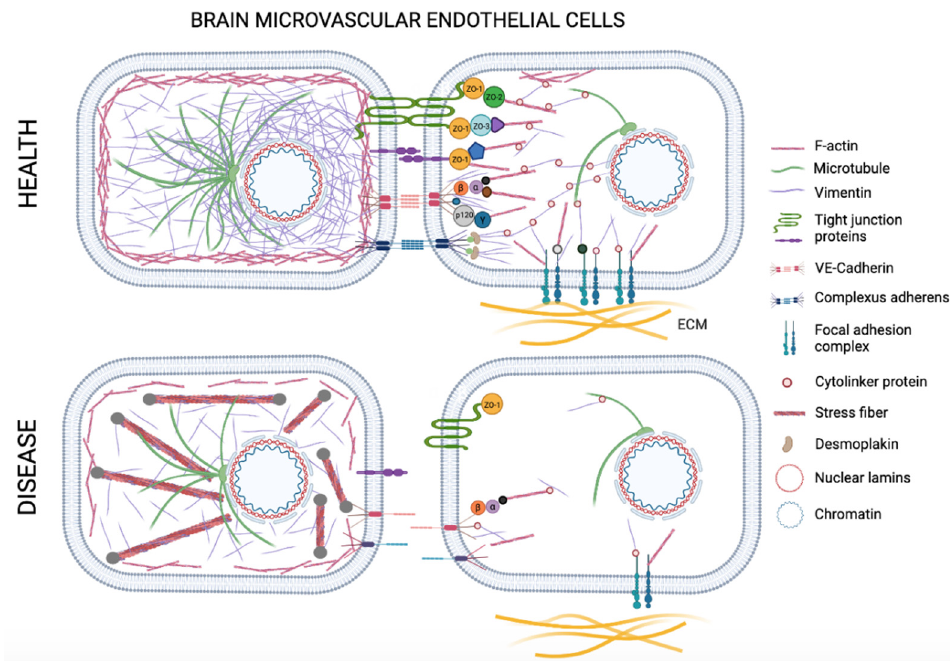
Figure 4. Schematic representation of the cytoskeleton and the interactions of transmembrane proteins with cytoskeleton proteins and the nucleus in brain microvascular endothelial cells (BMECs) in health and disease. In healthy conditions cortical actin ring supports and stabilizes the cell membrane outward. Cytoskeleton and cortical actin ring join cell–cell and cell–matrix adhesion complexes. Microtubules interact with actin directly or indirectly through intermediate filament proteins or signal molecules. Vimentin intermediate filament provides structural support and mechanical integrity to the cells. Transmembrane tight junction proteins, adherens junction and complexus adherens proteins associate and bind to each other across the intercellular cleft. These proteins link to the cell cytoskeleton directly or via cytolinker proteins. In disease conditions vimentin network is destroyed, the cell loses actin organization, and stress fibers increase in endothelial cells creating higher contractility. The adhesion complex structure reorganizes, and because of the loosening of cell–cell and cell–matrix junctions, gaps occur in the intercellular connections. Cells pull out from each other and barrier permeability increases. Created with BioRender.com (accessed on 21, May, 2021).